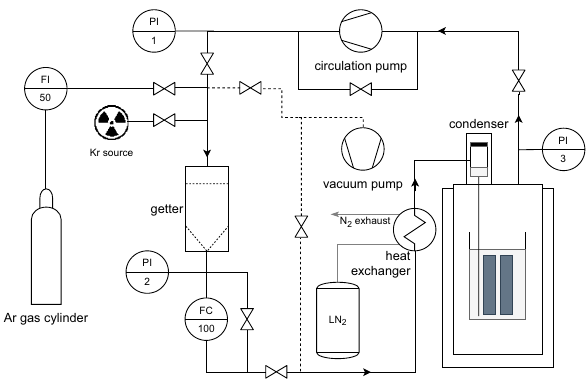
Fig. 2 The STAR (SiPM Testbench in Argon) cryogenic